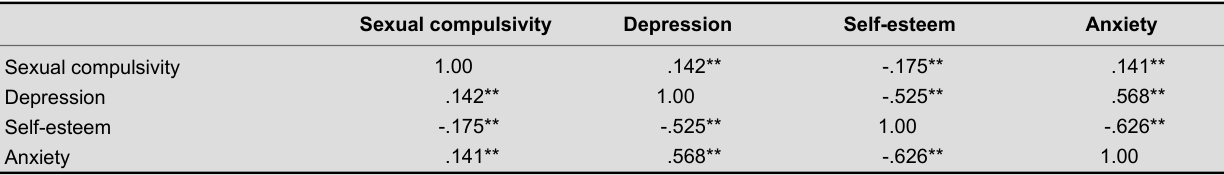
Sexual Compulsivity Comorbidity With Depression and Anxiety AnxietySelf-esteemDepressionSexual compulsivity Sexual compulsivity .141**.175**-.142**.001 Depression .568**.525**-.001.142** Self-esteem .626**-.001.525**-.175**- Anxiety .001.626**-.568**.141** **p < .01,